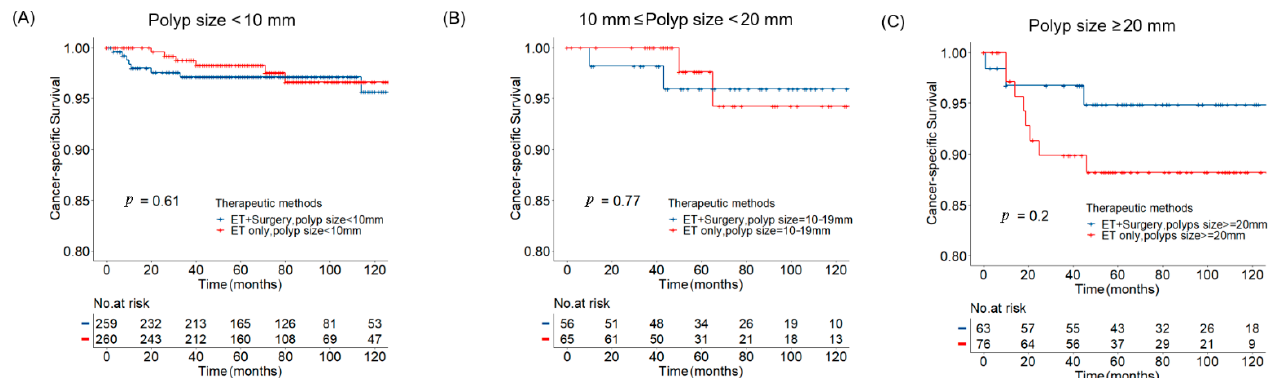
Figure 3. Kaplan–Meier cancer-specific survival plots in patients underwent endoscopic removal of invasive neoplasia. ( A ) Invasive polyp size less than 10 mm; ( B ) invasive polyp size between 10 mm and 20 mm; ( C ) invasive polyp size larger than 20 mm. Table 2. The 5 year cancer-specific survival for different treatment modalities among patients with endoscopic removal of invasive neoplasia.